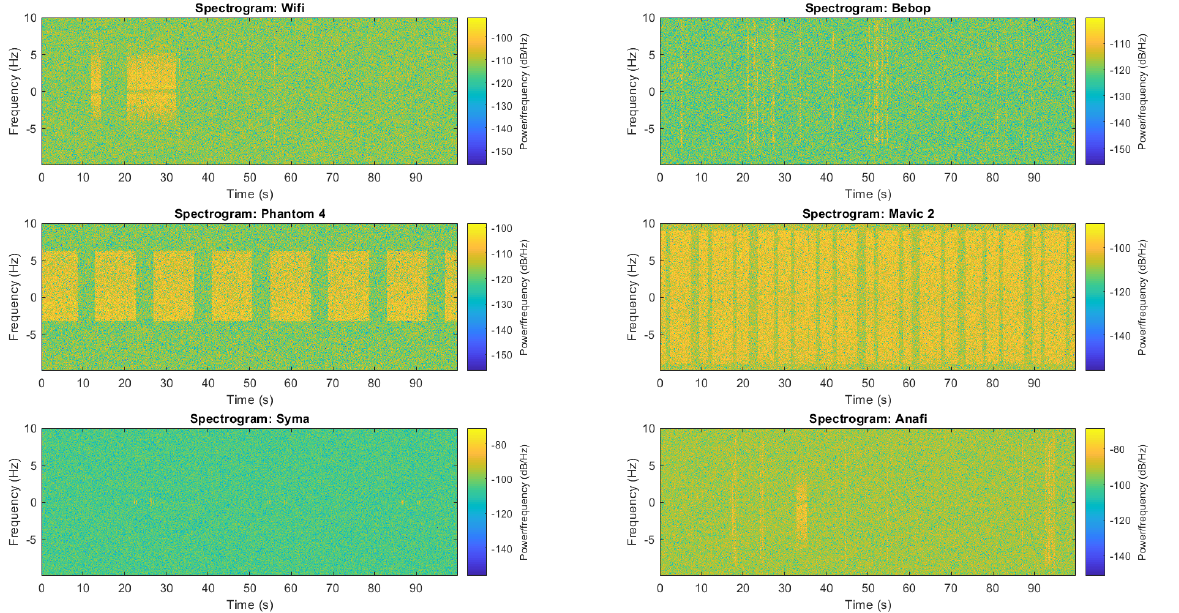
Figure 2. Spectrogram of drones